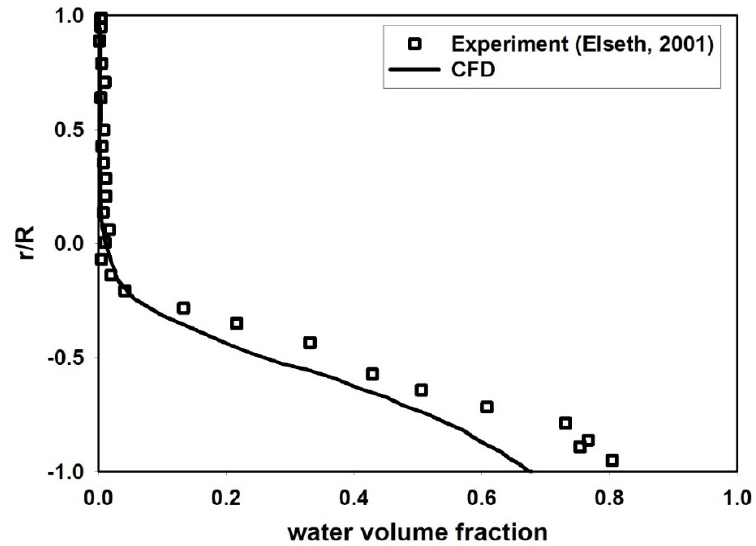
Figure 13. Vertical profile of in situ water volume fraction as measured in the experiment and predicted by CFD model for test 4 (mixture velocity = 1 m/s, water cut = 0.1).